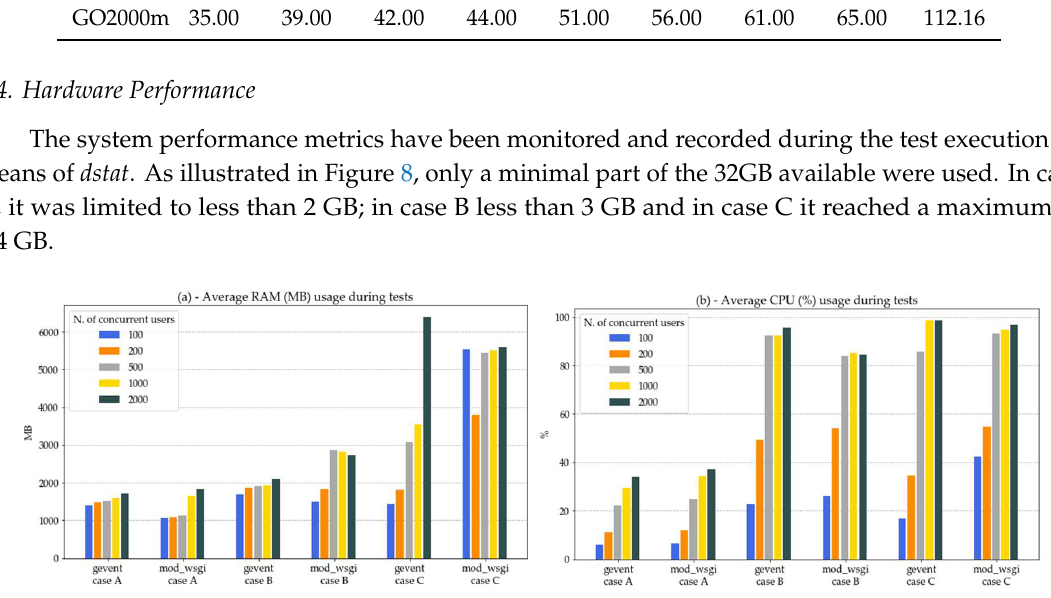
Figure 8. Average RAM (a) and processors (CPU) (b) usage during different test cases and concurrent users